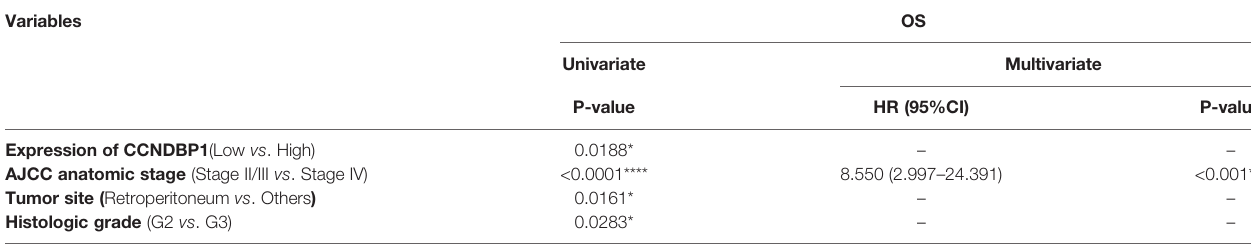
TABLE 3 | Univariate and multivariate analysis affecting the overall survival of